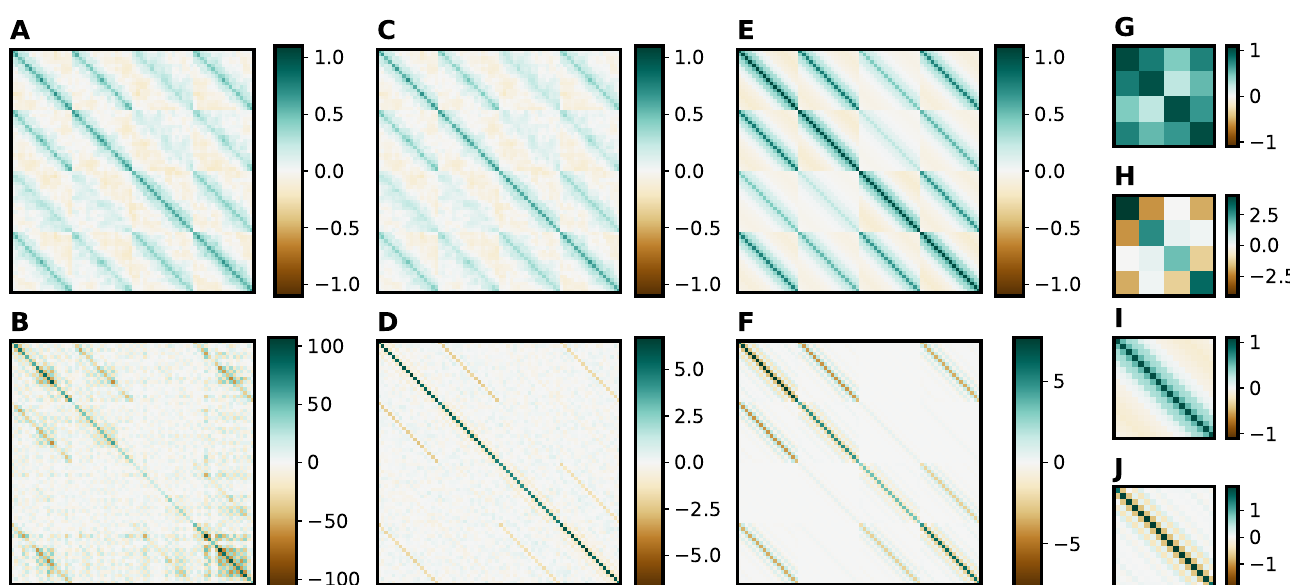
Figure 1. Different estimators of the covariance and inverse covariance of 100 epochs of data from Subject 01 for channels Fz , Cz , Pz , and Oz and time samples between 0.1 s and 0.6 s. Regularized estimators of the inverse covariance exhibit less extreme values and have a sparser structure. ( A , B ) Empirical covariance and inverse covariance matrices. ( C , D ) Shrunk covariance and inverse covariance matrices with α = 0.14 as determined by the closed-form leave-one-out cross- validation (LOOCV) method. ( E , F ) Kronecker–Toeplitz-structured covariance and inverse